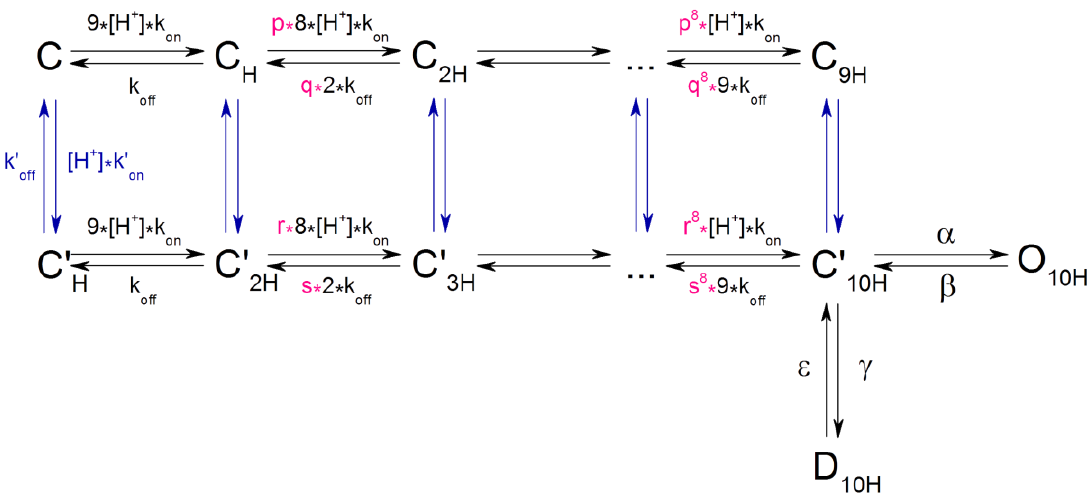
Scheme 1. Model 3 – 10 with ten consecutive H + binding steps.